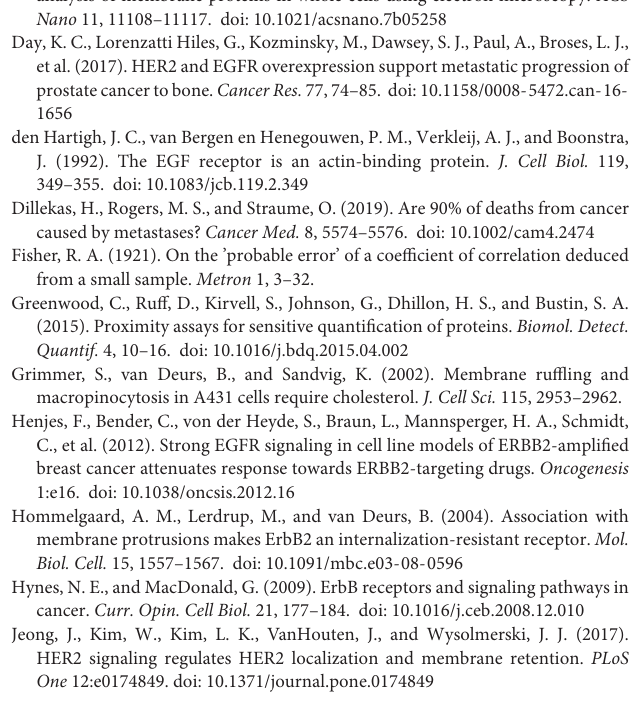
same positions. (C) Quantum dot (QD)-stained ErbB2 molecules overlay with actin-containing peripheral ruffles. (D) Overlay of the DIC, GFP and QD-channel as displayed in (A–C) . FIGURE S2 | ErbB2 stained SKBR3 cell without actin-GFP. (A) Cropped fluorescence micrograph of SKBR3 breast cancer cells showing QD-labeled membrane ErbB2 in red. Cell marked with ∗ was lost during EM preparation process. (B) Corresponding low magnification scanning transmission electron micrograph of graphene covered breast cancer cells taken at the same area, Magnification M = 1000 × . (C) High resolution scanning transmission electron (STEM) micrographs of region marked in a-b. QD-labels appear as white dots, M = 100,000 × . (D) Pair correlation function g ( r ) as function of pair distance r of QD-labeled ErbB2 in flat regions without actin-GFP. FIGURE S3 | Correlative fluorescence microscopy and STEM of whole breast cancer cells after treatment with Cytochalasin D. (A–C) Cropped fluorescence micrographs of SKBR3 breast cancer cells showing cellular actin-GFP in green, and QD-labeled membrane ErbB2 in red. Areas were both signals overlay appears yellow. Image A was taken at the baseline before treatment with Cytochalasin D (1 h, 2 µ M) and staining of QDs. Image B was acquired immediately after Cytochalasin D treatment and labeling of ErbB2 with QDs. Image C was generated of maximum intensity overlays of deconvoluted z-stacks from the same spot as in A and B. Cells that disappeared during Cytochalasin D treatment and EM preparation process are marked with white asterisks in image A. (D) Corresponding low magnification scanning transmission electron micrograph of graphene covered breast cancer cells taken at the same area, M = 1000 × . (E,F) High resolution scanning transmission electron micrographs of region marked in a–d. QD-labels appear as white dots in (F) . E: M = 30,000 × , F: M = 100,000 × . (G) Graph of pair correlation function g ( r ) as function of pair distance r of QD-labeled ErbB2 in peripheral cellular regions containing actin-GFP as displayed in (A–F) . Note the peak at 20 nm which is similar to the one of actin-rich areas in untreated cells. TABLE S1 | Summary of scanning transmission electron microscopy (STEM) data used for label distribution analysis of STEM images acquired at actin-rich regions of Cytochalasin D (Cyt D) treated SKBR3 breast cancer cells that were transduced with actin-green fluorescent protein